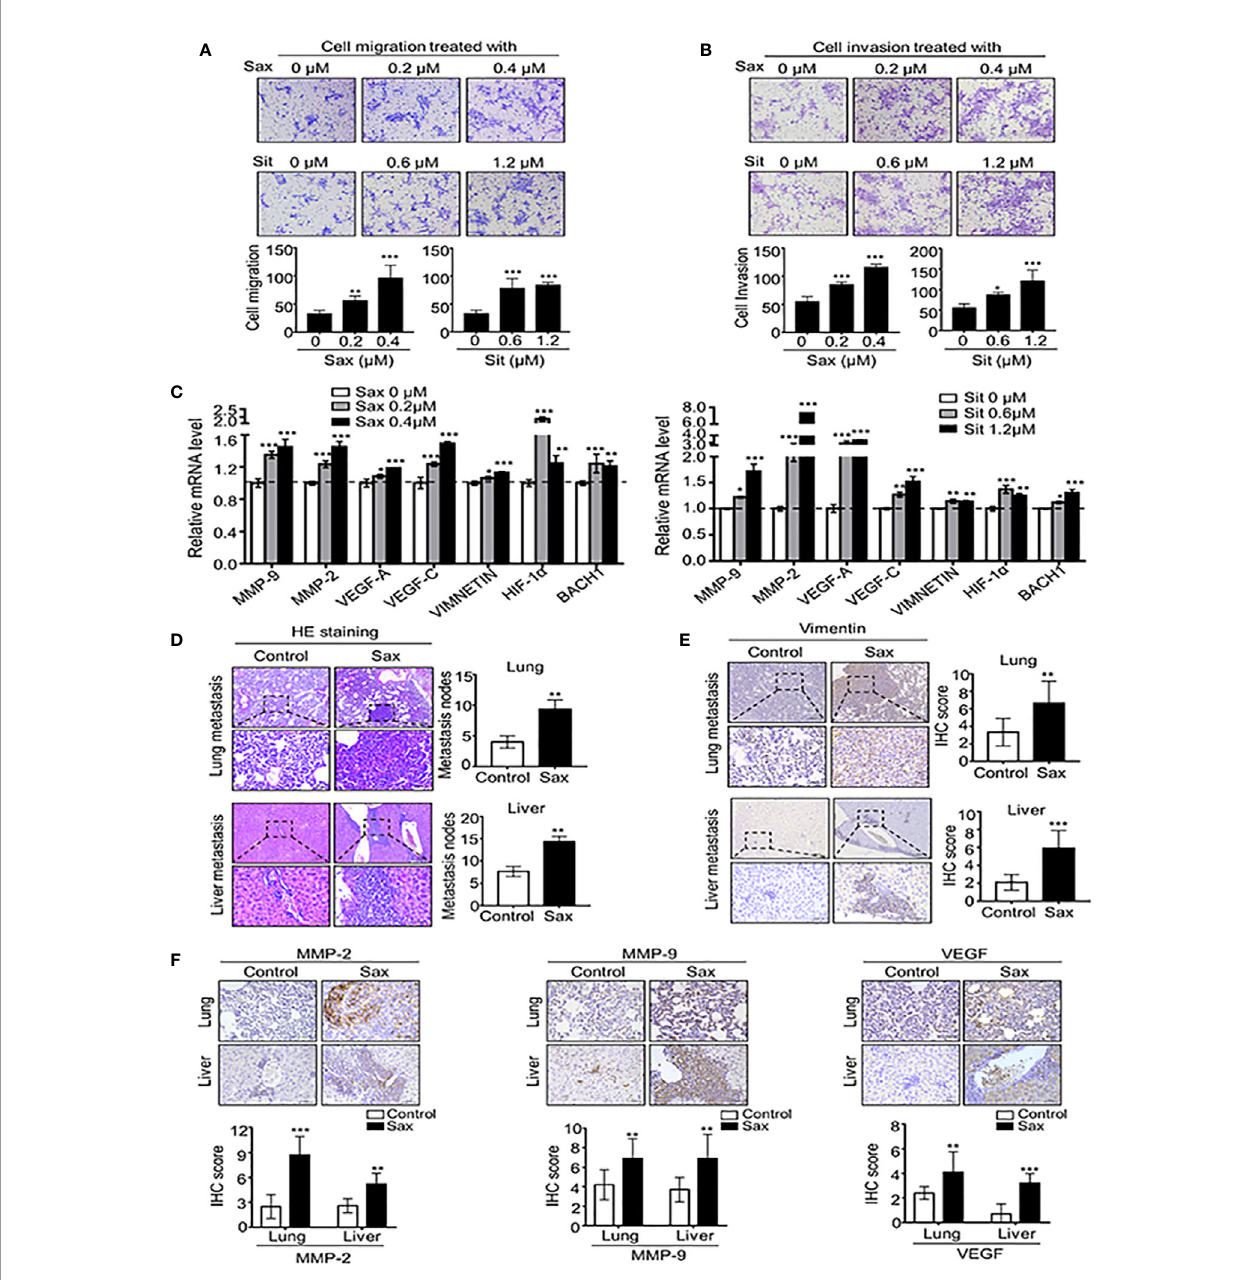
FIGURE 1 | DPP-4i(Sax and Sit)promotes murine breast cancer metastasis in vitro and in vivo . (A, B) DPP-4i (Sax and Sit) facilitates cells migration and invasion in vitro . 4T1 cells were subject to cell migration assay (A) and cell invasion analysis (B) upon treatment of Saxagliptin (Sax) or Sitagliptin (Sit). Migration or invasion cells were counted in 5 to 10 random fi elds. (C) DPP-4i increases metastasis-associated gene levels. 4T1 cells were co-treated with or without DPP-4i and metastasis- associated gene levels were detected by qRT-PCR. b -actin gene was as an internal control. (D) DPP-4i accelerates BC lung and liver metastasis in vivo . 1.0 × 105 4T1 cells in 100 m l PBS buffer were injected into in the left mammary fat pad of female NOD-SCID mice. Post-injection 3 to 5 days, mice were randomly allocated to the indicated groups (n = 3 – 5 mice/group) and treated with 0.9% NaCl (control) or 15 mg/kg Sax via oral gavage daily. After the indicated time, lungs and livers were collected, and metastatic nodes were counted by H&E staining (D) . Micro-metastasis marker vimentin was detected by IHC staining (E) . DPP-4i enhances metastasis-associated gene expression in vivo (F) . 4T1-bearing mice were treated with DPP-4i (Sax) as above mentioned and metastasis-associated proteins MMP- 9, MMP-2 and VEGF were detected by IHC staining in lung and liver metastatic tissues. Data are presented as mean ± SD of three independent experiments. Representative images are shown. Scale bar: 50 m m. *p < 0.05, **p < 0.01, and ***p < 0.001 between the indicated groups determined by unpaired Student ’ s t test or the one-way analysis of variance